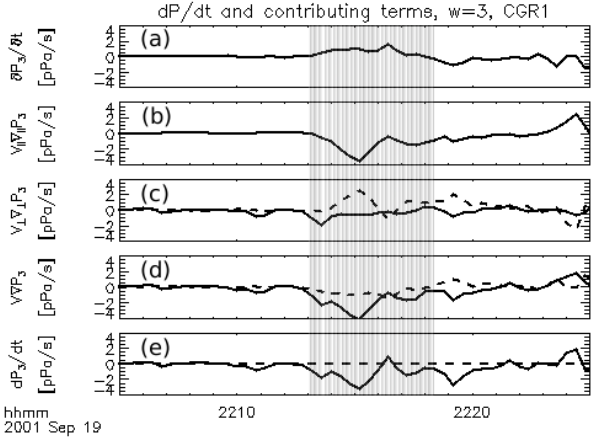
Fig. 9. Time derivative of the pressure in the plasma frame, d p/ d t = ∂p/∂t + v ·∇ p , and the contributing terms, when ∂p/∂n is esti- mated based on ∇ p k J × B (solid lines), respectively on d p/ d t = 0 (dashed lines). All the quantities are computed for w = 3. (a) Time derivative in the satellite frame, ∂p/∂t . (b, c) Contributions to v ·∇ p from the spacecraft plane, v k ·∇ k p , and from the normal direction, v ·∇ ⊥ p = v n ∂p/∂n . (d) Total v ·∇ p , the sum of (b) and (c). (e) To- tal d p/ d t , the sum of (a) and (d). As required, when stationarity is assumed v ·∇ p = − ∂p/∂t (compare the dashed line in panel (d) with panel